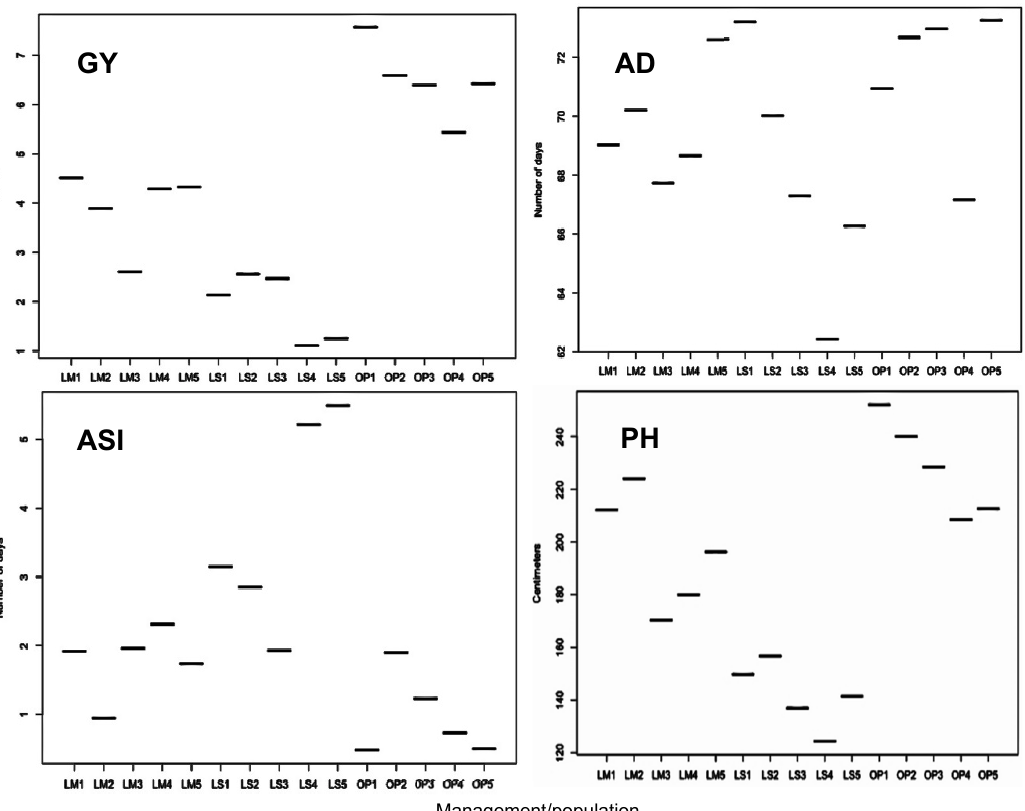
Figure 1. The mean of grain yield (GY), anthesis date (AD), anthesis-silking interval (ASI), and plant height (PH) under optimum (OP), moderately low-N stress (LM) and severely low-N stressed (LS) conditions. The numbers after the management conditions on x axis indicate populations 1 to 5.